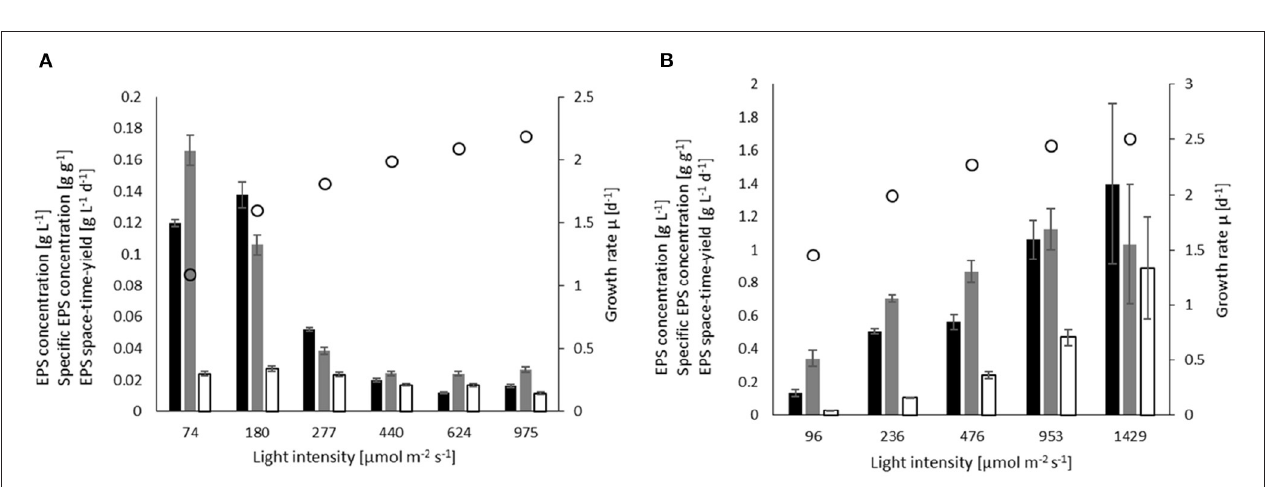
simulated using K S = 61.2 µ mol m − 2 s − 1 and µ max = 2.39 d − 1